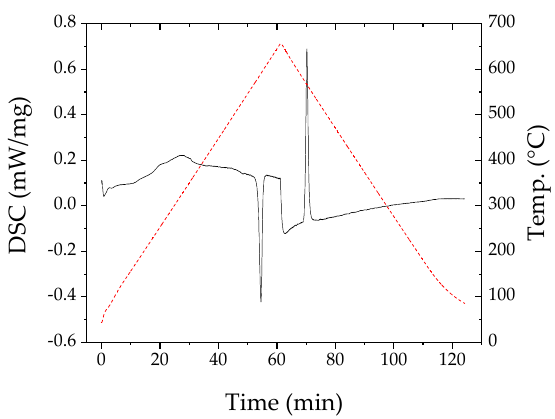
Figure 2. Differential scanning calorimetry (DSC) results for dry p-type paste (red dotted line shows temperature curve).